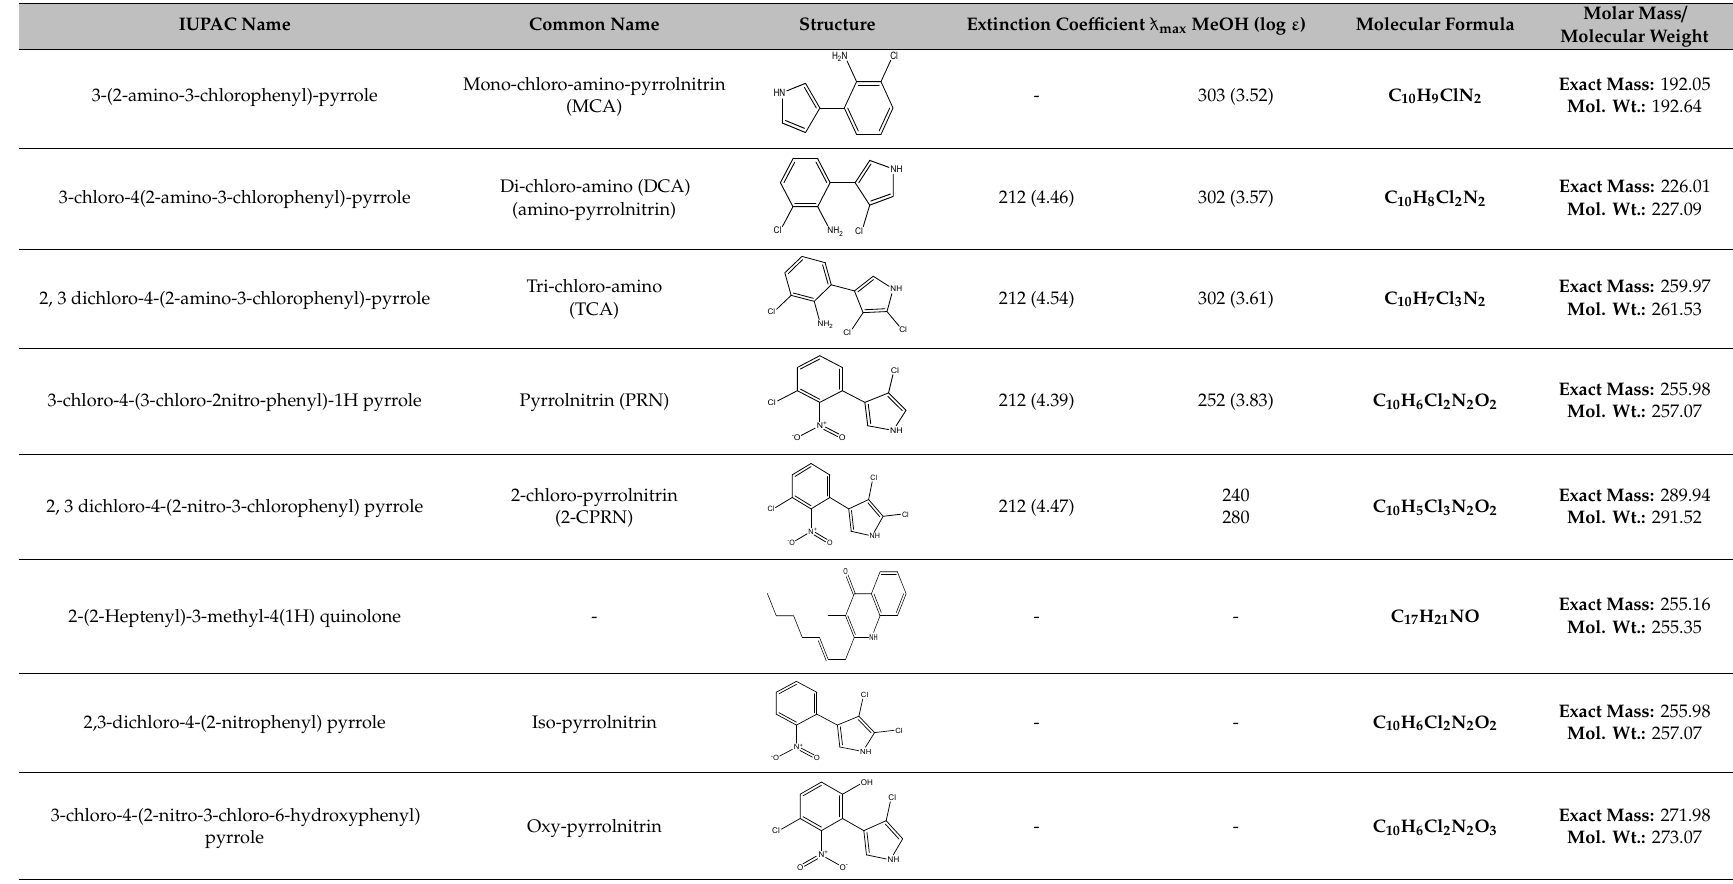
Table 2. Derivatives of pyrrolnitrin biosynthesized by Pseudomonas aureofaciens [56].